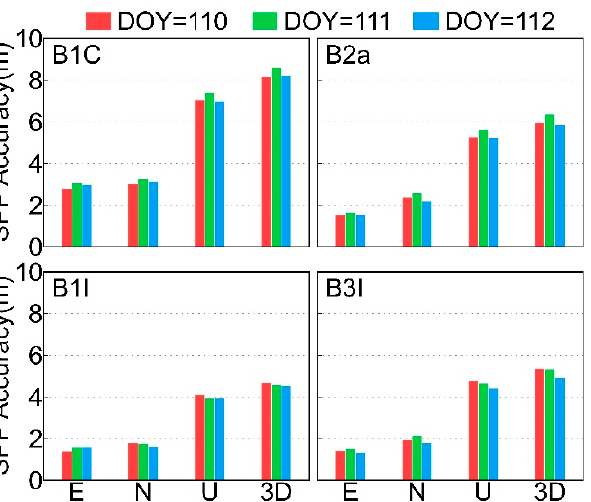
Figure 9. The average positioning accuracies of SPP with the novel ( top ) and the legacy ( bottom ) signals before (red), during (green) and after (blue) the day on which geomagnetic storm occurred. Shown in Figure 10 are the time series of positioning errors at the station GUA1 during the three days around the geomagnetic storm. On the day of the geomagnetic storm, the vertical accuracies of SPP with B1C, B2a, B1I and B3I signals decreases by 0.34 m, 0.64 m, 0.17 m and 0.06 m, respectively, while the horizontal accuracies keep stable for all of the four